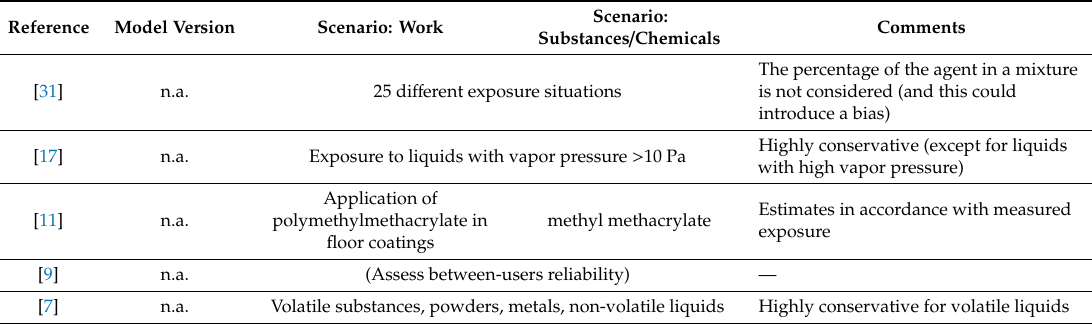
Table 8. Summary of articles concerning the EMKG model found in our